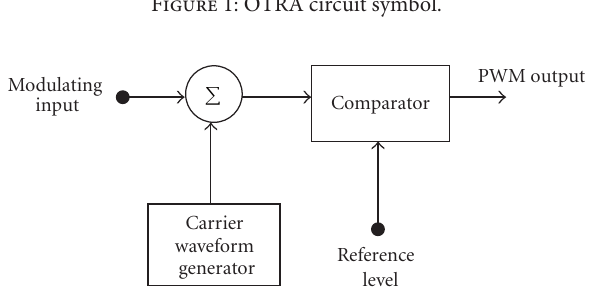
Reference level